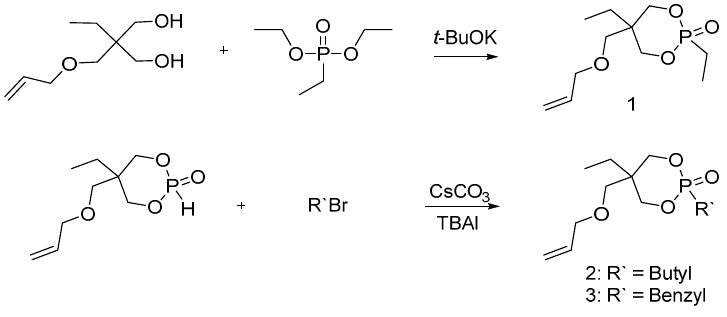
Figure 3. Representative synthesis of monomers ( 1 ), ( 2 ) and ( 3 ).